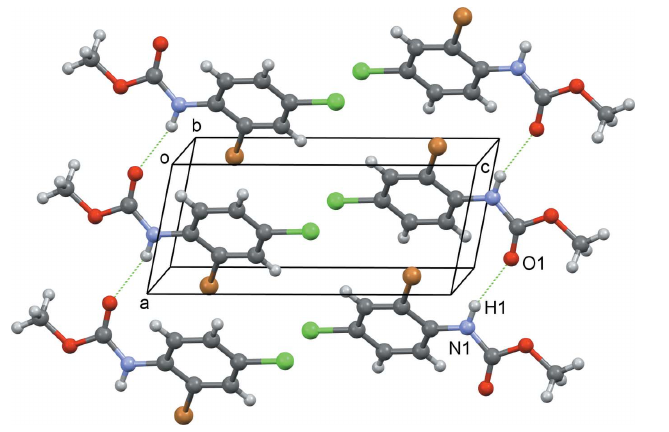
Figure 2 A segment of the crystal structure, viewed along b , showing the N— H (cid:3)(cid:3)(cid:3) O hydrogen bonds as dotted